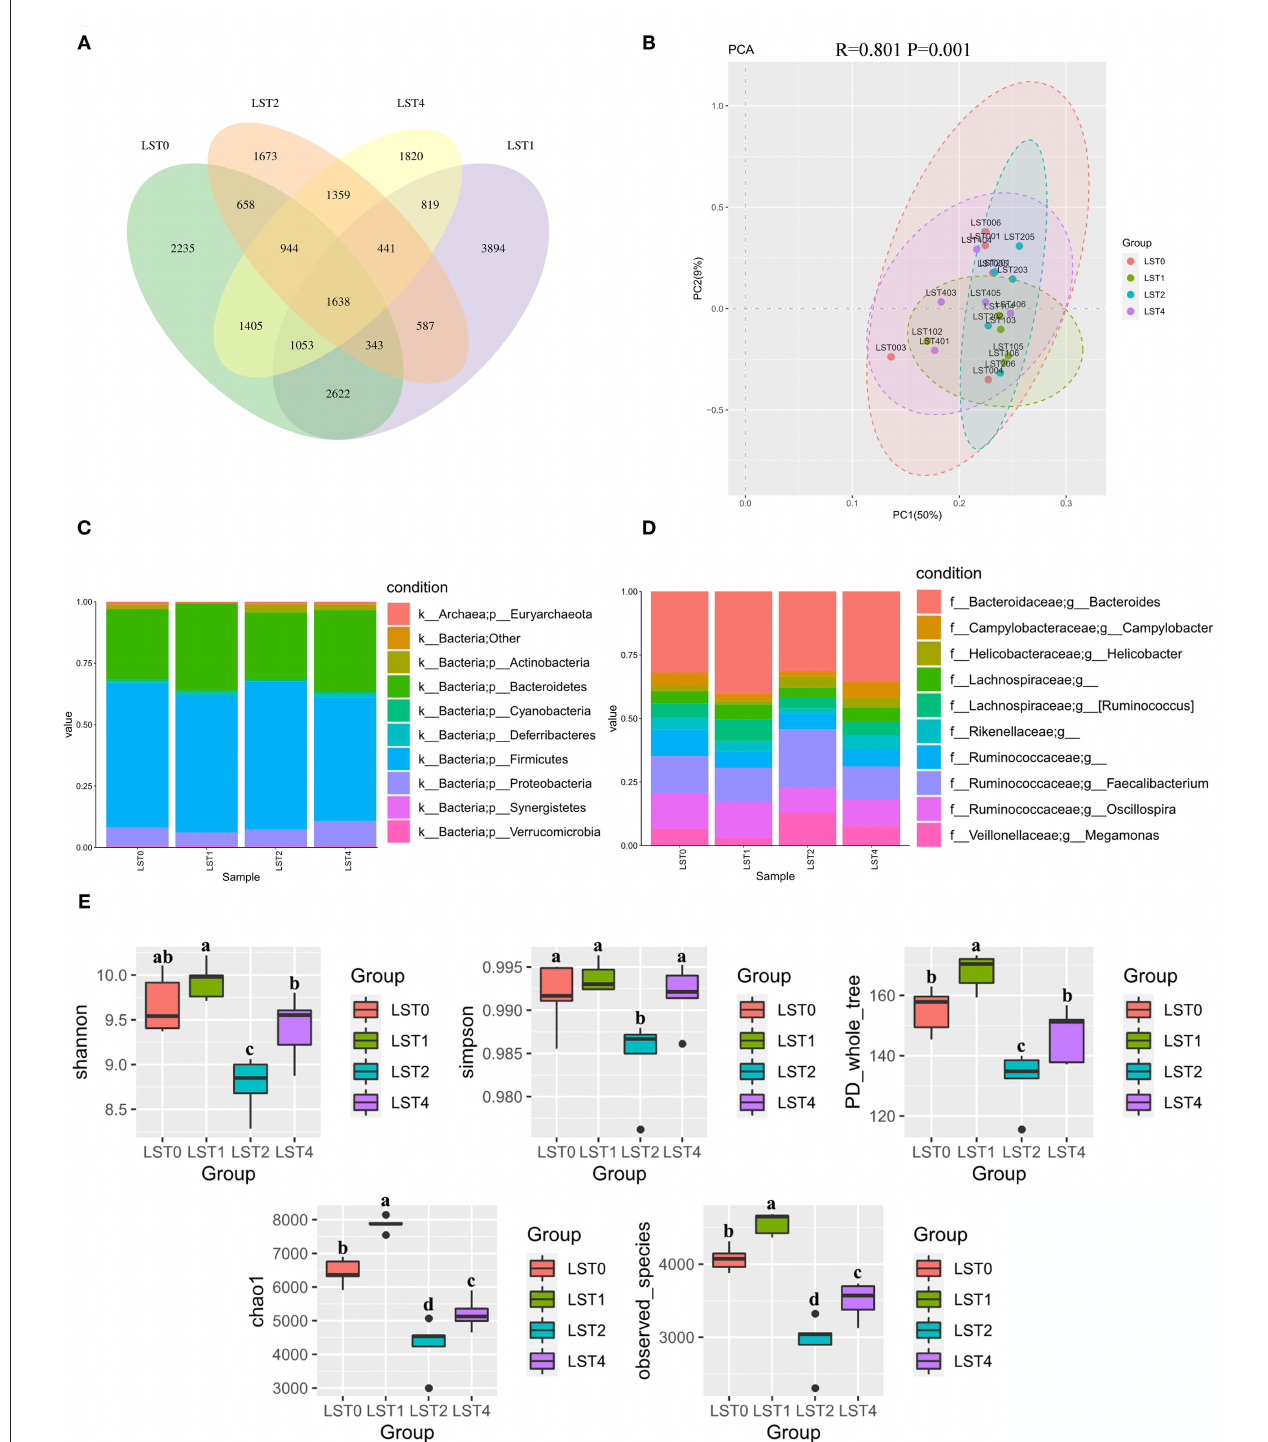
FIGURE 2 | Abundance and diversity of microbial community in cecal contents of broiler chickens after dietary supplementation of LST powder for 42 days. (A) The Venn diagram summarizing the numbers of common and unique OTUs in the microflora community. (B) The PCA plot about the cecal microflora. (C,D) Microbial composition at the phylum and genus level. (E) α -diversity about the cecal microbial community. a − d Boxes followed by different letters differ significantly ( p < 0.05), followed by no or same letters indicated no significant difference ( p > 0.05). OTUs, operational taxanomic units; PCA, principal component analysis; LST, Lasia spinosa Thw.; LST0, control diet; LST1, 1% supplementation level of LST powder; LST2, 2% supplementation level of LST powder; LST4, 4% supplementation level of LST powder.